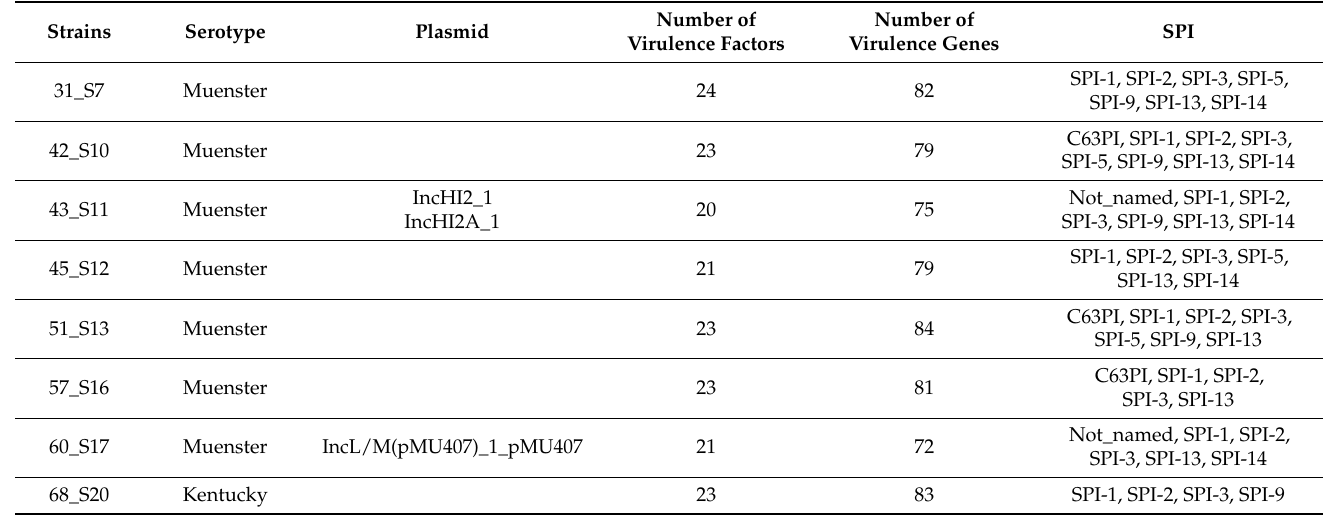
Table 4. Plasmids, virulence factors, and SPI